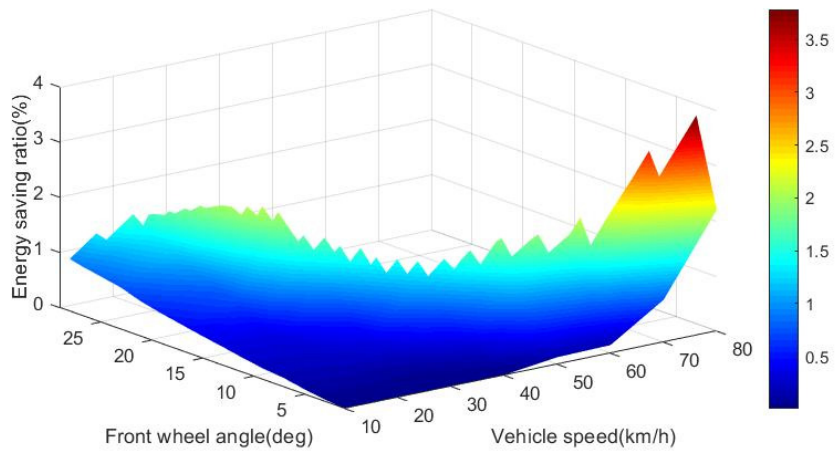
Figure 7. Energy ‐ saving effect of optimal torque distribution. Figure 7. Energy-saving effect of optimal torque